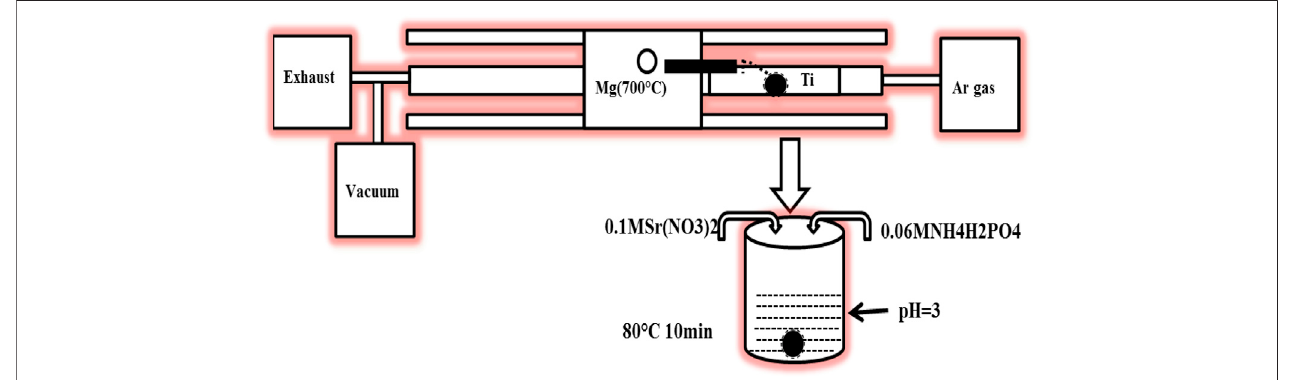
FIGURE 1 | The schematic diagram for Mg and Mg/SrP